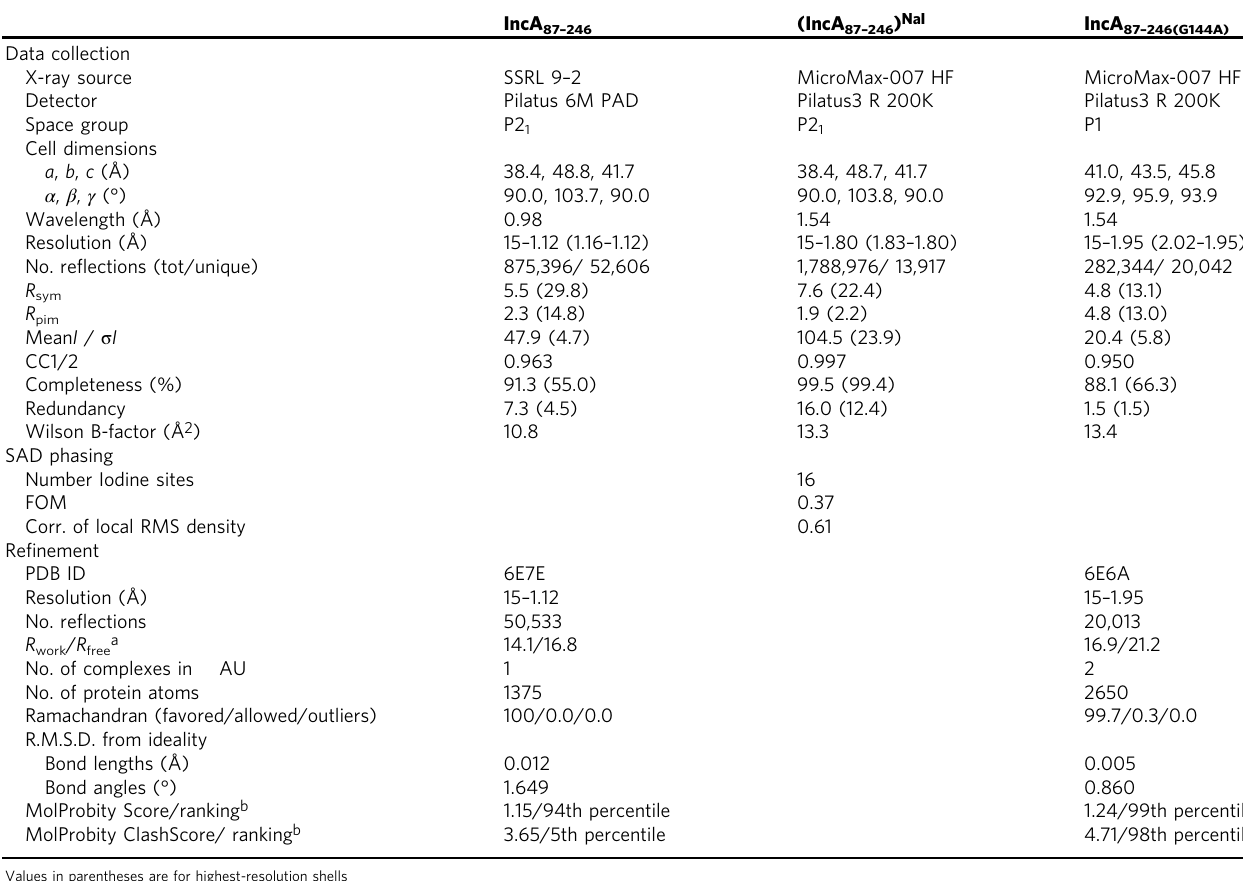
Table 1 Crystallographic data collection, phasing, and re fi nement